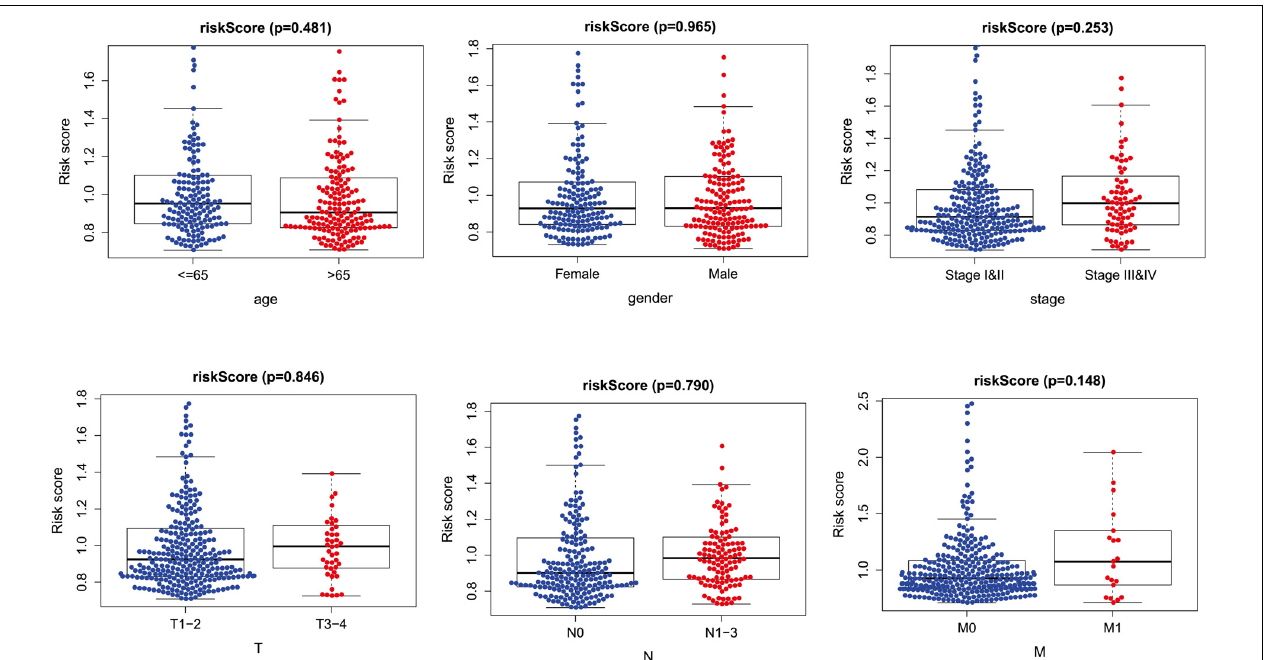
FIGURE 6 | The relationships between two PM-related genes and clinical prognostic features. PM, platelet and